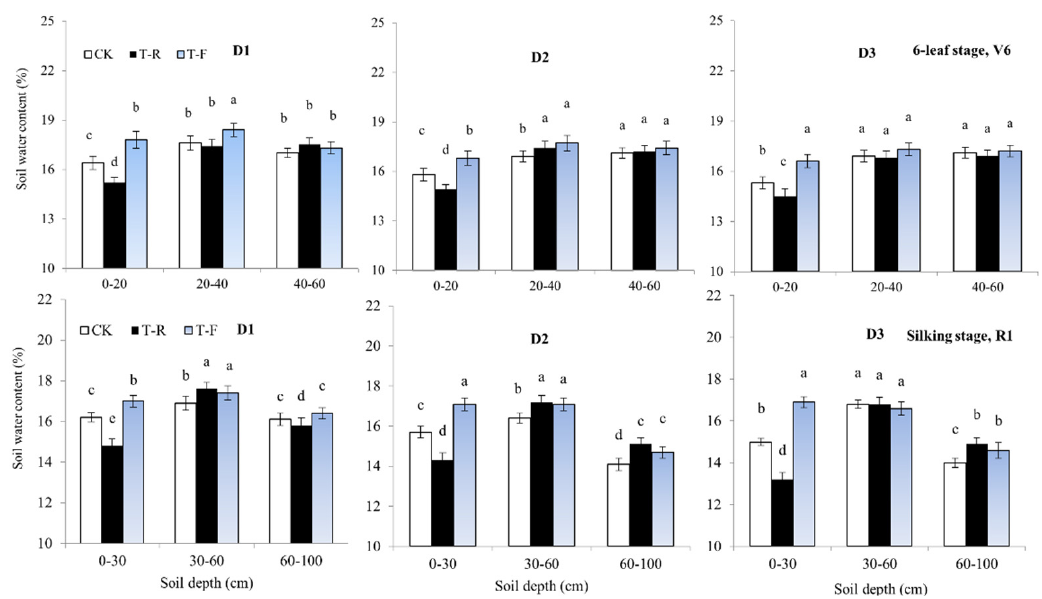
Figure 3. Soil water content under different planting patterns (2018). Different letters above the bars indicate that there is a significant difference between treatments at p < 0.05. D1, D2 and D3 represent maize were planted at 60,000, 75,000 and 90,000 plants ha − 1 , respectively. CK and T represent maize were planted in the conventional flat planting pattern and in the stereo-planting pattern, respectively. T-R and T-F represent maize were planted on the ridge and in the furrow, respectively. Vertical bar means the standard errors ( n = 3).